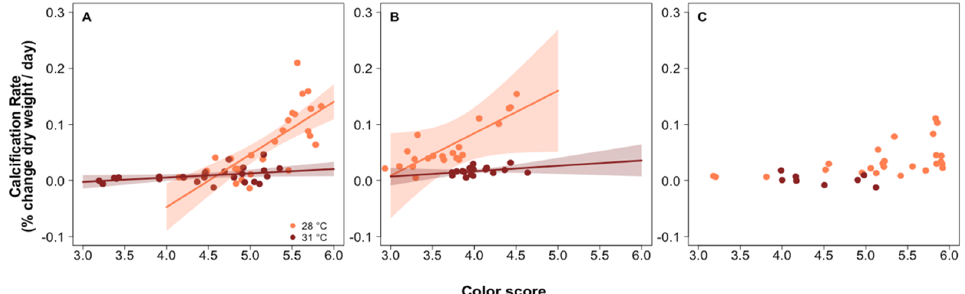
Figure 7. The relationship between coral color score and calcification rate of three species of tropical corals (( A ): S. pistillata ; ( B ): S. hystrix ; ( C ): P. damicornis ). Color score is a proxy for photosymbiont abundance (‘bleaching’), where ‘0’ = bleached and ‘6’ = healthy. Trendlines indicate significant correlations between color score and calcification rate at 28 (orange) and 31 (red) ◦ C. Temperature significantly impacted the relationship between color score and calcification rate of S. pistillata , and caused a significant decline in calcification rate of S. hystrix . No significant relationship existed between calcification rate and color score of P. damicornis , and temperature had no significant impact on this relationship. Shaded boundaries represent 95% confidence intervals.